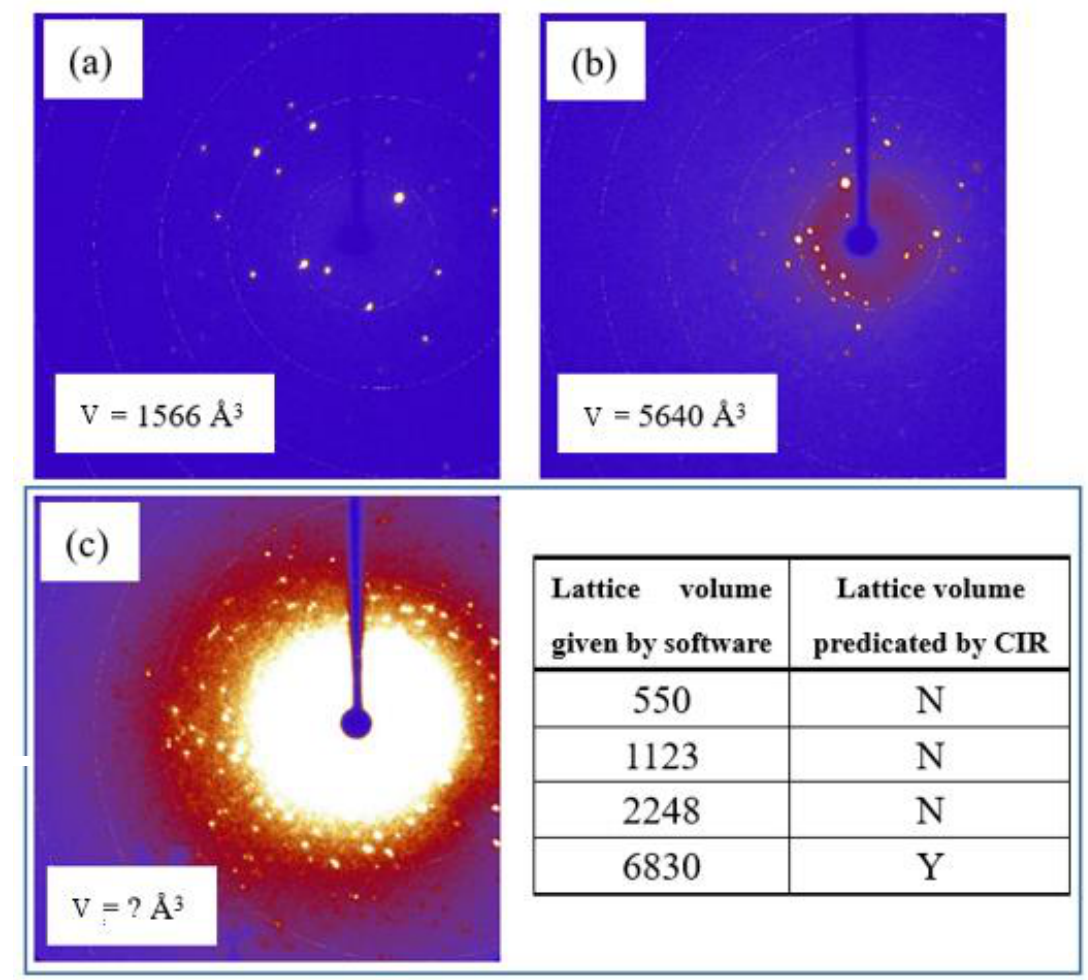
Figure 3. The correlation between the diffraction pattern and the real lattice volume (V) according to ( a ) a smaller and ( b ) a larger lattice volume, ( c ) varieties of lattice volume values will be provided (insert table) on a low-quality sample with blurred diffraction pattern. CIR method may be employed to assist the users for the predication of the lattice volume range.